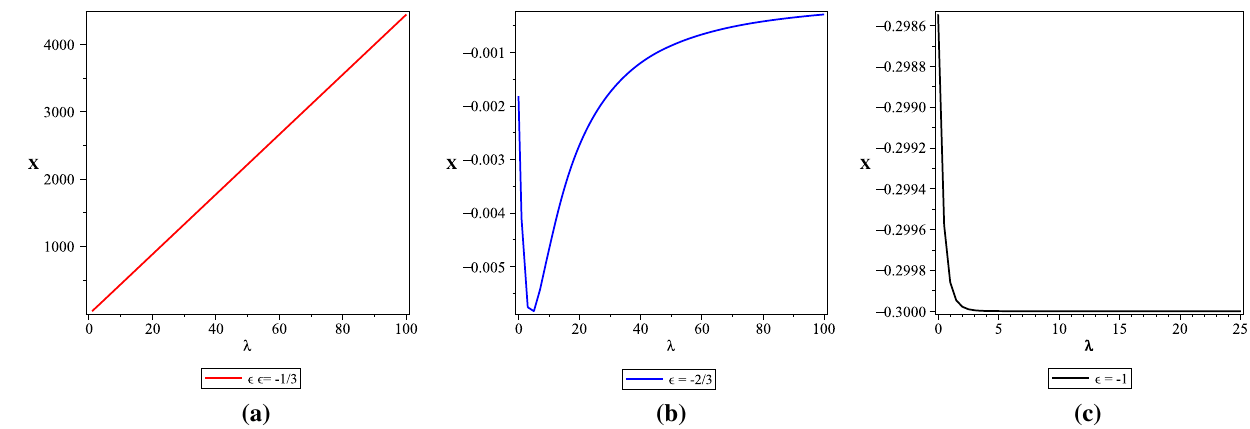
( a ) (b) (c) Fig. 3 Evolution of X with the affine parameter λ , where E = 0 . 95 , L = 6 . 5 ,α = 0 . 1 , M = 1 , Q = 0 . 5 for different values of